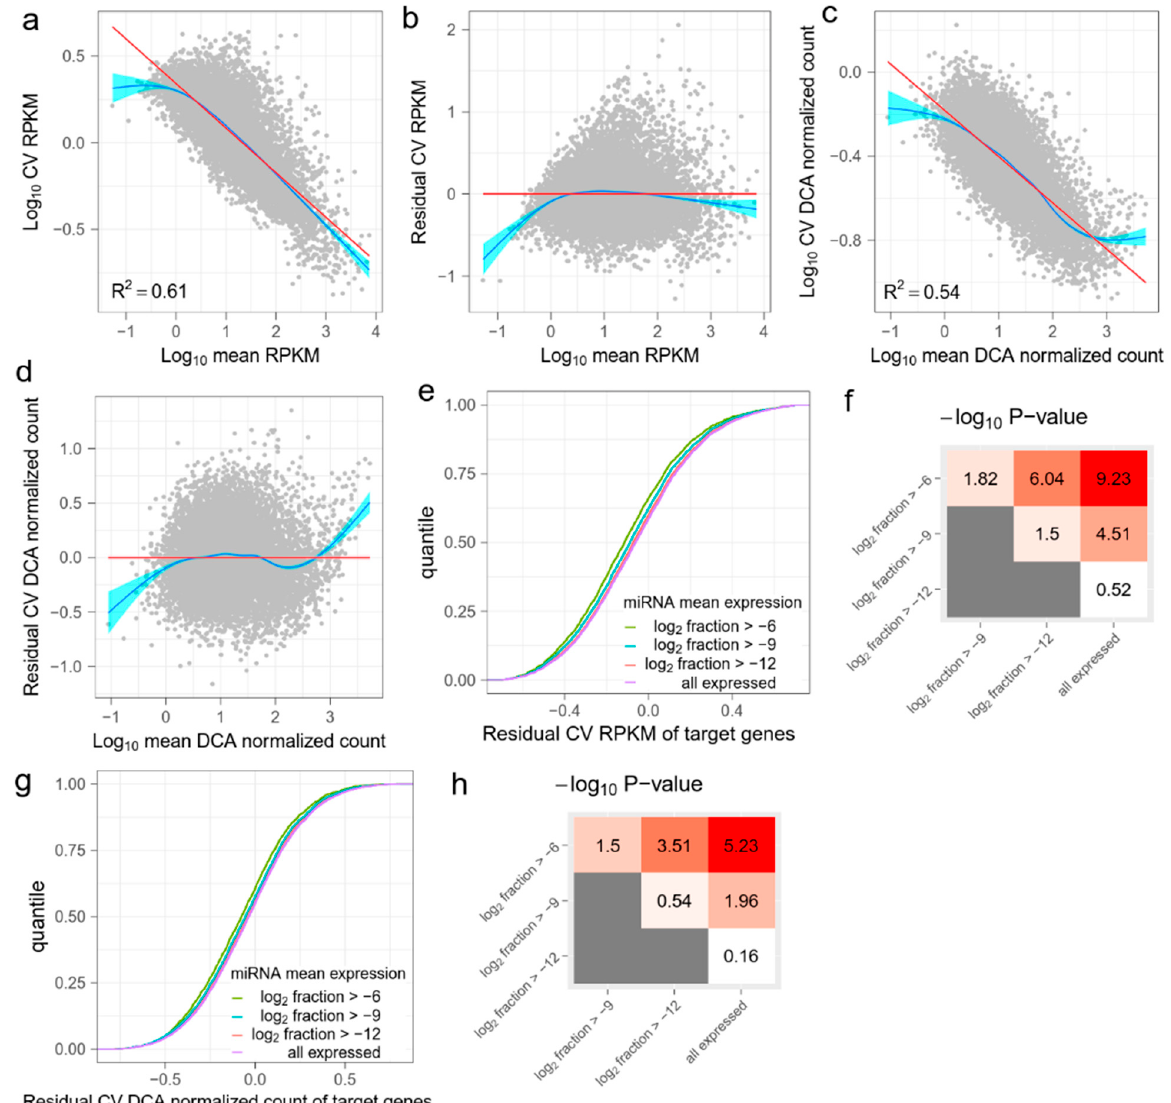
Figure 1. The effect of miRNA on target mRNAs in GSE81287 primed ESCs. ( a ) The linear relation between the mean and the coefficient of variation (CV) of RPKM values of genes. The red line is fitted by ordinary least squares regression and the blue line is fitted by the smoothing method, Generalized Additive Models. ( b ) Residual CV (RCV) RPKM is defined as log10 (CV) RPKM, after regressing out the mean RPKM. Overall, RCV RPKM measures the relative noise of mRNAs compared with the mean noise of mRNAs with the same expression level. ( c ) Raw read counts are denoised by DCA and then normalized. The relation between the mean and the CV of DCA normalized counts is also linear. ( d ) RCV is also calculated for DCA normalized data. ( e ) Cumulative distribution functions (CDFs) of RCV RPKM of target mRNAs. Target genes are grouped by miRNA mean expression levels. As the miRNA mean expression level increases, the RCV RPKM of the target genes significantly decreases. ( f ) Kolmogorov–Smirnov (KS) test − log10 ( p ) values between CDFs in ( e ). Red indicates higher statistical significance and white indicates lower statistical significance. ( g ) CDFs of RCV DCA normalized count of target genes. Target genes are grouped by miRNA mean expression levels. ( h ) KS-test − log10 ( p ) values between CDFs in ( g ). Red indicates higher statistical significance and white indicates lower statistical